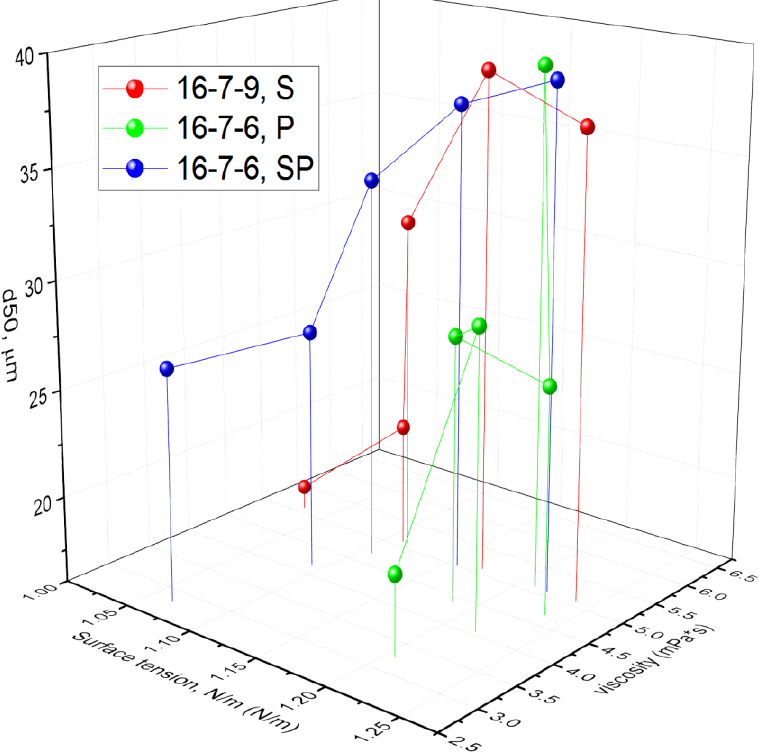
Figure 6. Surface tension modification [11], viscosity modification [12] and simultaneous viscosity and surface tension modification of liquid steel and their effect on the median particle size d 50 of the inert-gas atomized powder.